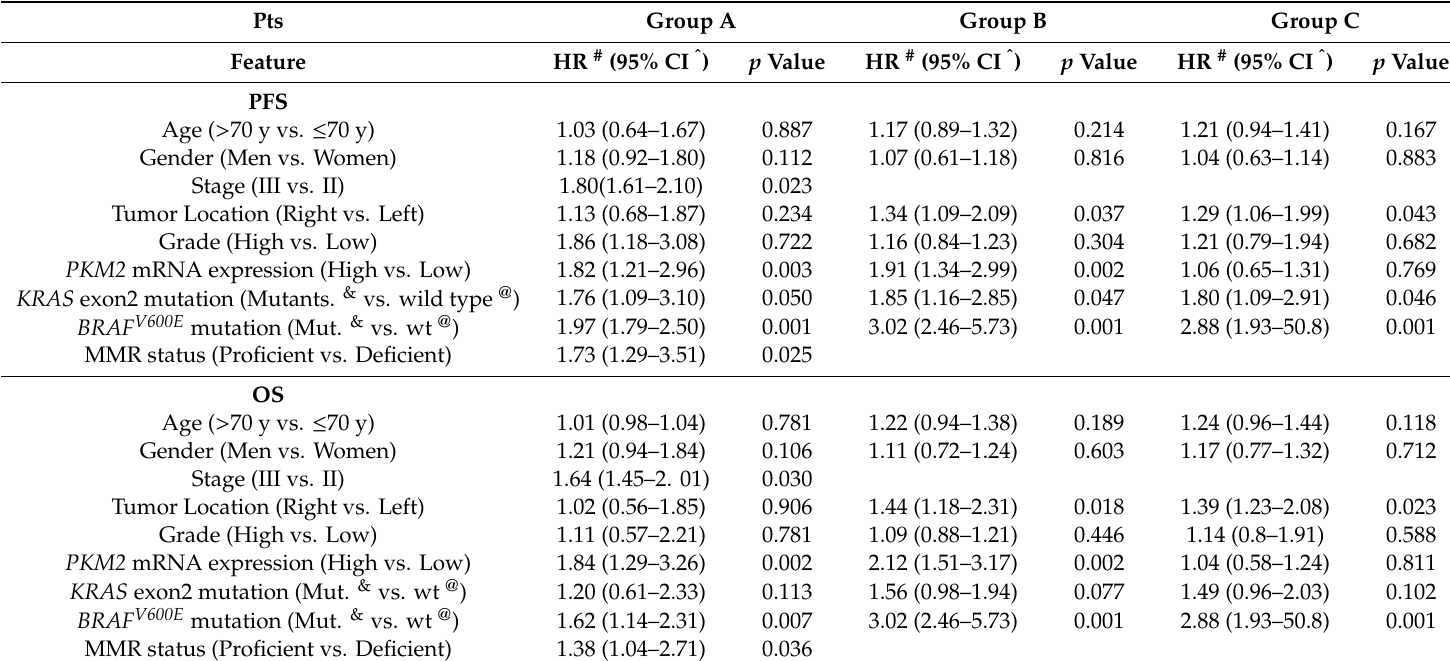
Table 3. Univariate analysis for progression free survival (PFS) and overall survival (OS). HR, hazard ratio; CI, confidence